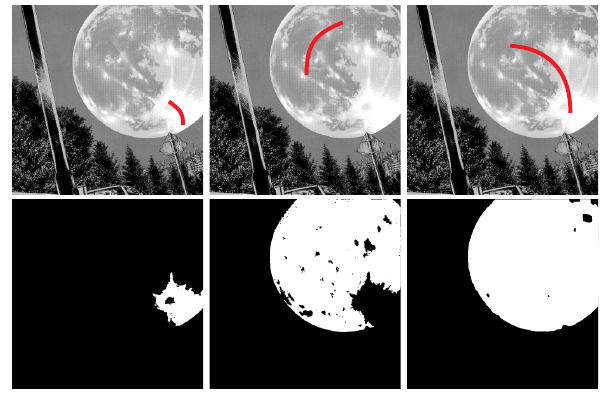
Fig. 6 Initial region extraction from strokes. Top: several user- specified strokes. Bottom: corresponding extracted initial regions.